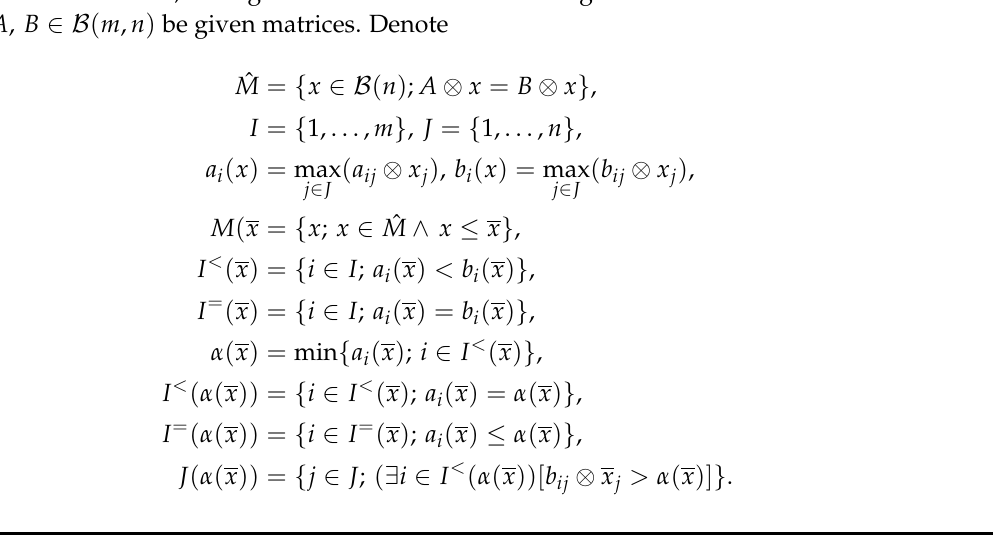
Algorithm 1: Solving a general two-sided system.